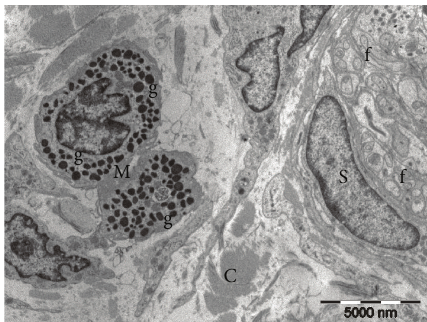
Figure 4: Electron microscopy image from the rat control group. Two dermal mast cells (M) with uniform electron-dense granules (g), placed near a nerve bundle containing a Schwann cell (S) and unmyelinated nerve fibers (f). Collagen (C) in the surrounding